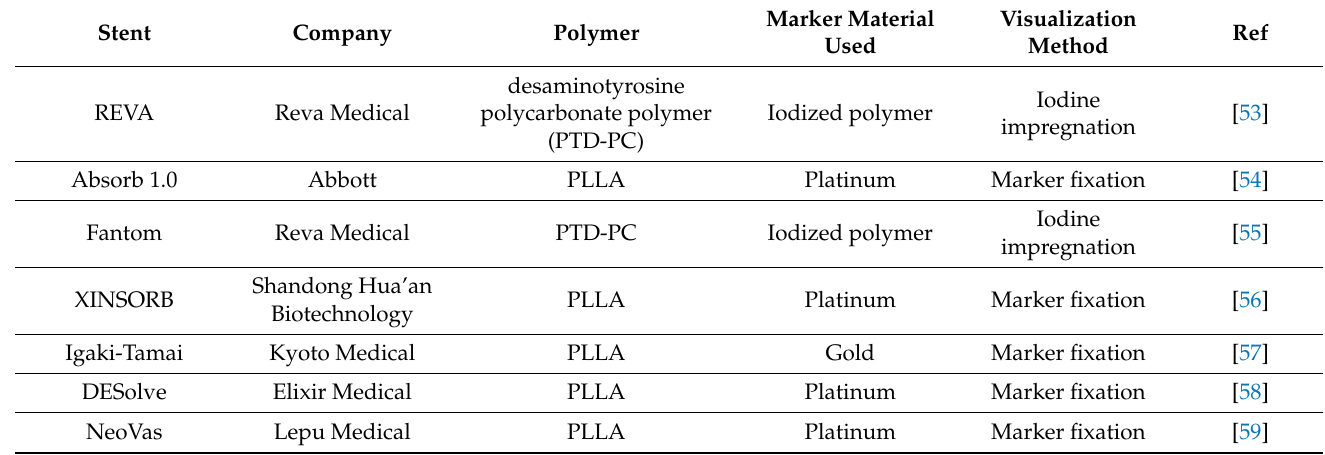
Table 3. The introduction of some commercial stent visualization methods.